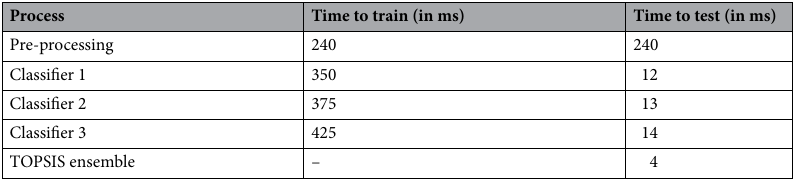
Table 5. Time required to process 16 sample images at a time. The training time reported is recorded as the sum of total time required to train for each epoch. The time reported is the average of five independent runs.